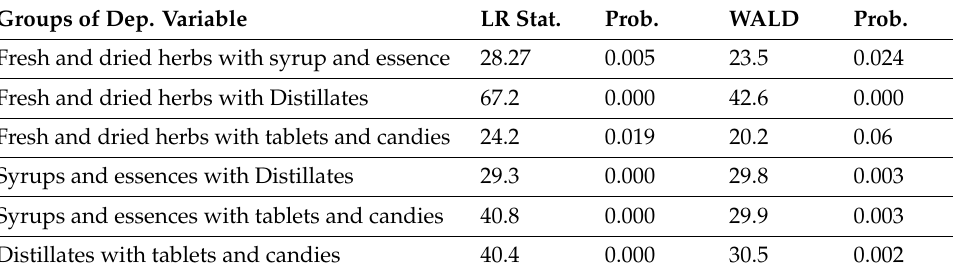
Table 6. Results of LR and WALD